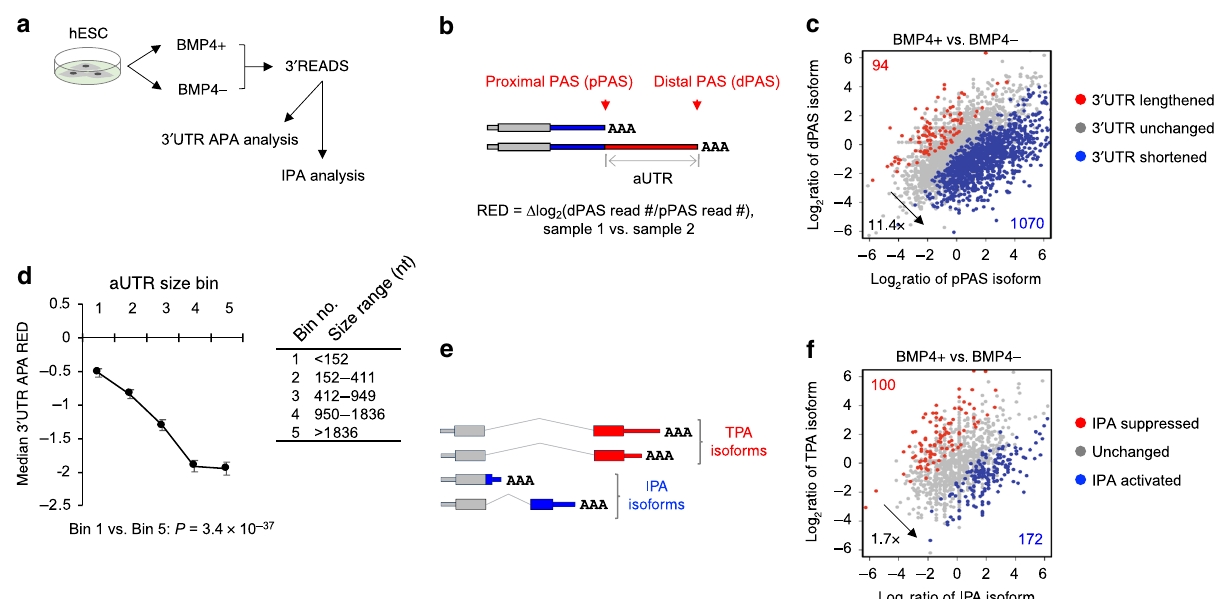
Fig. 2 Widespread 3 ʹ UTR shortening and IPA activation in trophoblast differentiation. a Schematic of 3 ʹ READS experiment using hESCs (H9 line) treated with BMP4 for TB differentiation. b Schematic of 3 ʹ UTR APA analysis using 3 ʹ READS data. Two representative 3 ʹ UTR isoforms are selected, named proximal and distal PAS (pPAS and dPAS) isoforms, respectively. RED is calculated as indicated. c Scatter plot showing 3 ʹ UTR APA changes. Each dot is a gene with two selected 3 ʹ UTR isoforms. The numbers of genes showing signi fi cantly lengthened 3 ʹ UTRs (red) or shortened 3 ʹ UTRs (blue) are indicated, and so is the ratio of these two numbers. Signi fi cance here and other panels of this fi gure is based on P < 0.05 (Fisher ’ s exact test) and > 20% change of expression ratio of the two isoforms. d Relationship between aUTR size and degree of 3 ʹ UTR size regulation (represented by RED). Genes are grouped into fi ve similarly sized bins (about 500 genes each) based on their aUTR length. aUTR size range for each bin is shown in a table. Data are presented as median value ± SEM. P -value (Wilcoxon test) comparing Bins 1 and 5 is indicated. e Schematic of intronic polyadenylation (IPA) isoforms and 3 ʹ terminal exon polyadenylation (TPA) isoforms. f Scatter plot showing IPA changes. Each dot is a gene with expression of both IPA and TPA isoforms. The numbers of genes with signi fi cant IPA suppression (red) or IPA activation (blue) are indicated, and so is their aUTR (illustrated in Fig. 2b), we divided genes into fi ve bins (Fig. 2d). Using relative expression difference (RED) to represent the degree of 3 ʹ UTR APA regulation (described in Fig. 2b), we found that genes tended to display a greater extent of 3 ʹ UTR shortening as aUTR size increased (Fig. 2d). For example, genes with an aUTR size >1836 nucleotides (nt, bin 5) showed much more conspicuous 3 ʹ UTR shortening than genes with an aUTR size <152 nt (bin 1, P = 3.4 × 10 − 37 , Wilcoxon test, Fig. 2d). A sizable fraction of APA sites are located in introns 11 , leading to IPA isoforms that have coding sequence changes in addition to 3 ʹ UTR alternations (illustrated in Fig. 2e). Using isoforms containing PASs in the 3 ʹ terminal exons as reference, we found with 1.7-fold more genes showing IPA activation than those